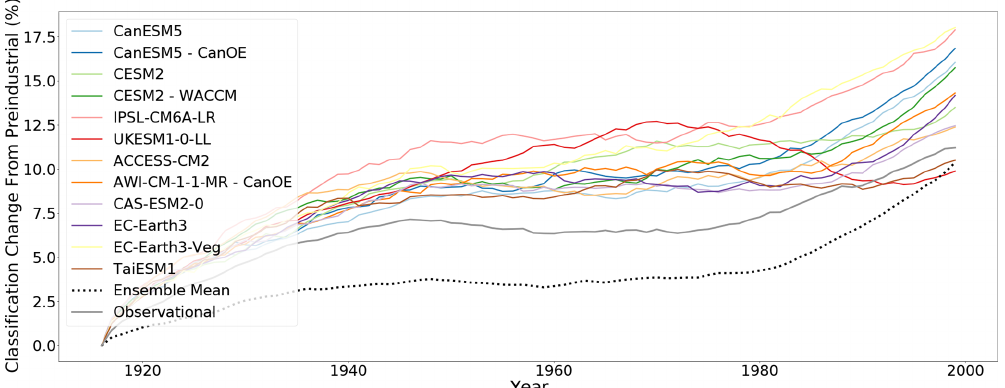
Figure 1. The percentage of land area change in KG classification for each model versus year through the 20th century (without anomaly correction). The equivalent trajectory based on the observed climate is shown for comparison in dark grey. The dotted line shows the trajectory derived from the ensemble mean climate.